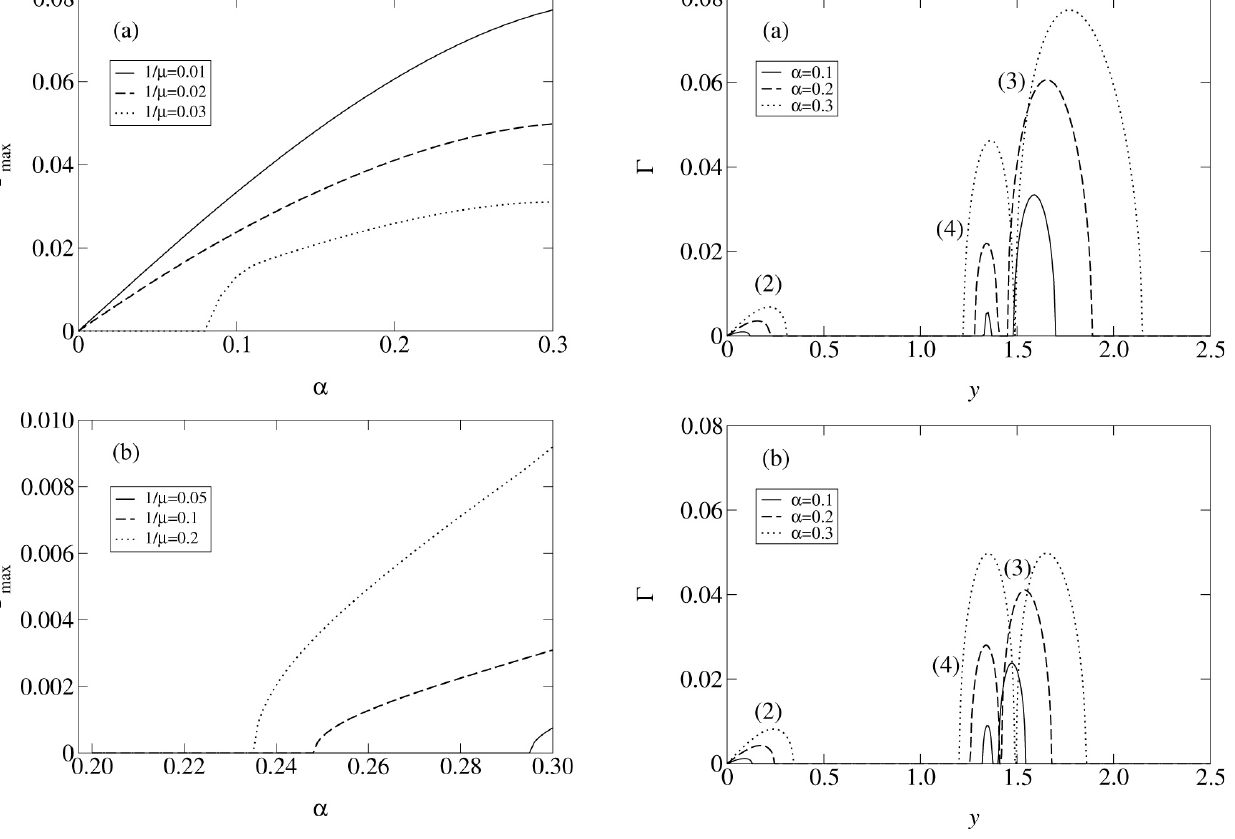
Fig. 15. Imaginary part of frequency vs. normalized wave number, for various values of the pump wave amplitude. Numerical labels for crossings are taken from Fig. 12. (a) 1 /µ = 0 . 01. (b) 1 /µ = 0 . 02.